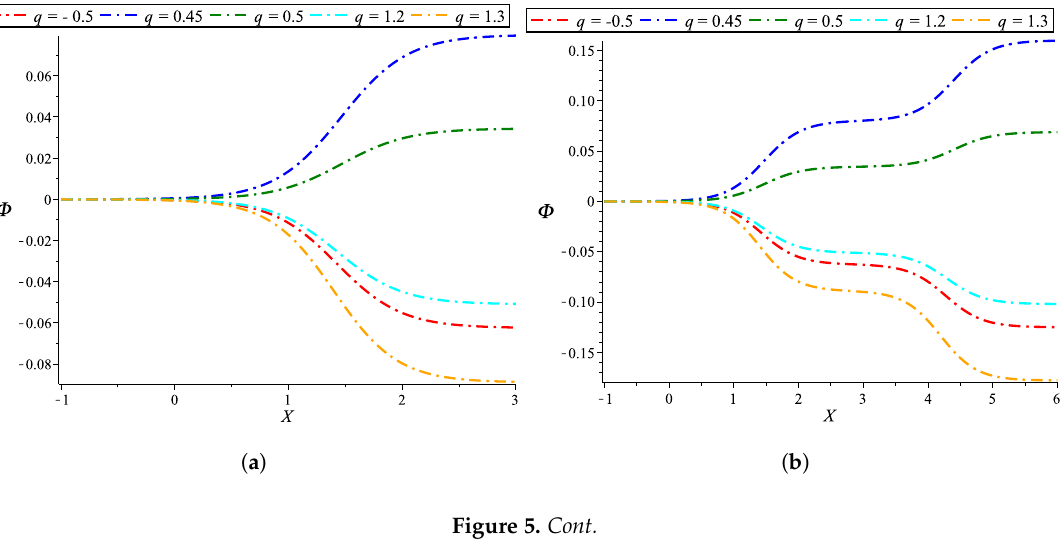
Figure 4. Effect of N r 2 when N r 1 = 0.1 on the electrostatic overtaking collision of ( a ) double-, and ( b ) triple-, and N r 1 when N r 2 = 0.8 on the electrostatic overtaking collision of ( c ) double-, and ( d ) triple-shock wave excitations, respectively, by choosing α = 0.3, q = 0.35, M r = 3.75, T ni = 0.05, T e = 0.2, µ pi = 0.35, µ ni = 0.05, and T = 10.